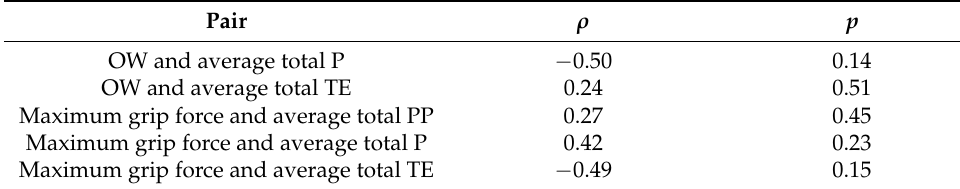
Figure 7. Average force pattern (red line) ± standard deviation (shaded area) and target force pattern (black dotted line) for the “Ramp”, “Square Wave”, and “Sinusoid”, level 1, for one representative volunteer who obtained average performances among the enrolled volunteers. The average force and standard deviation were computed for the 4 repetitions of level 1 for each exercise. Table 4. Spearman’s rank correlation coefficients and p